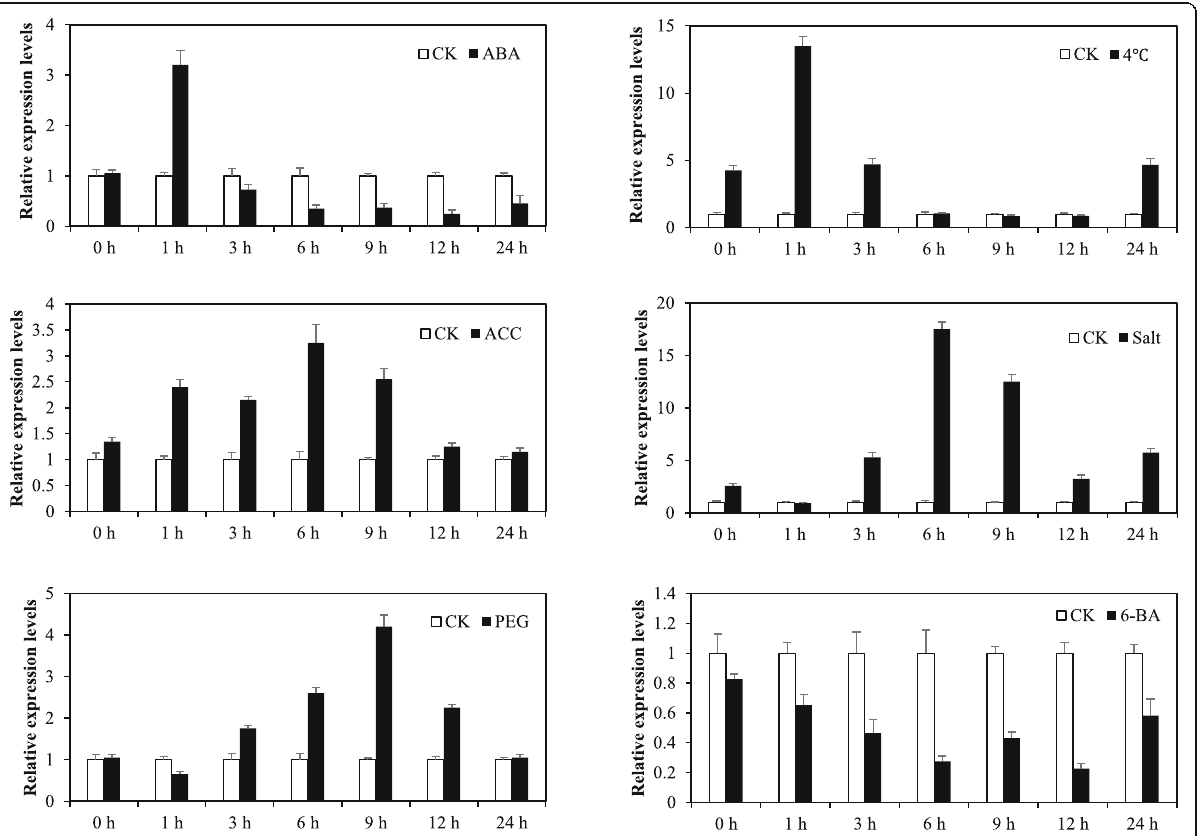
Fig. 2 Expression profiles of OsSTAP1 in response to various abiotic stress and phytohormones. Wild-type rice ( Oryza sativa L. ssp. japonica cv. ‘ Nipponbare ’ ) plants treated with 20% PEG, 150 mM NaCl, cold (4 °C), 100 μ M ABA, 100 μ M ACC, and 100 μ M 6-BA. Total RNA was isolated at the indicated times (hours) after each treatment. Error bars showing the SD based on three replicates. The Actin gene was used as the endogenous control for normalization of gene